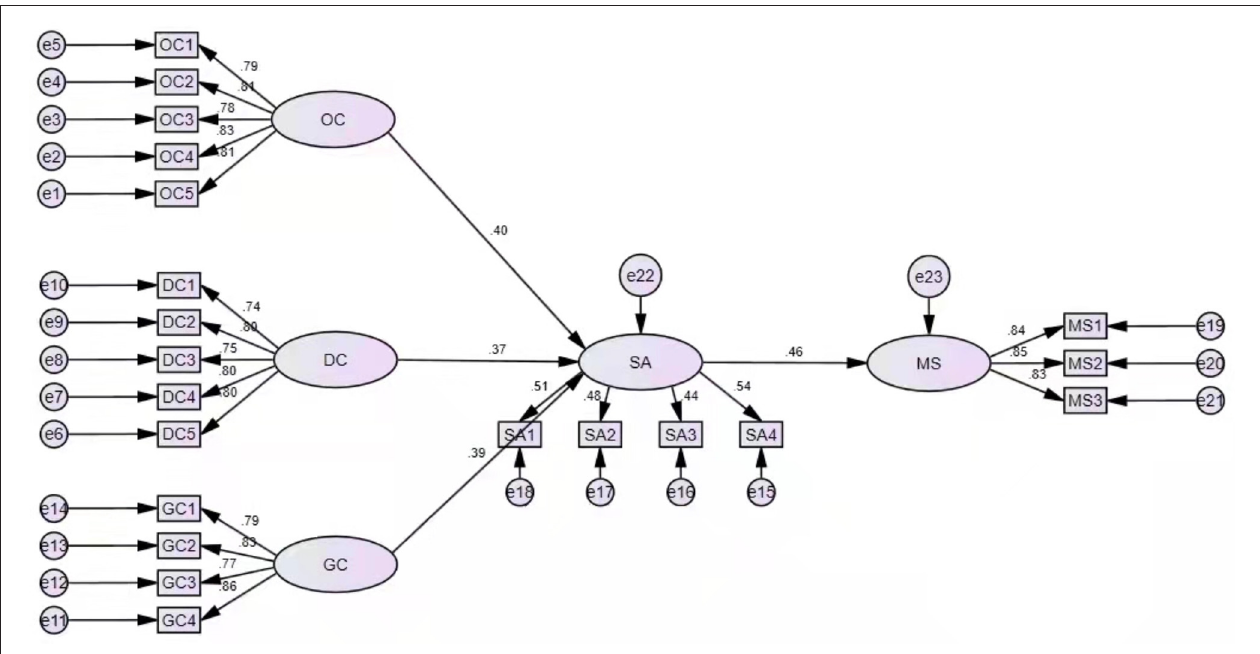
FIGURE 2 | Structure model.